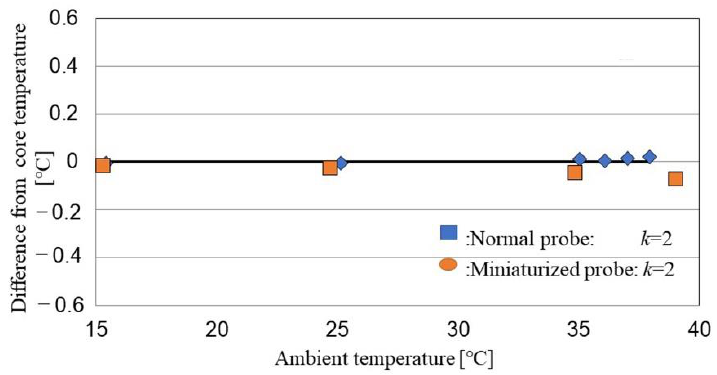
Figure 6. DBT error according to ambient temperature under the calibration system.